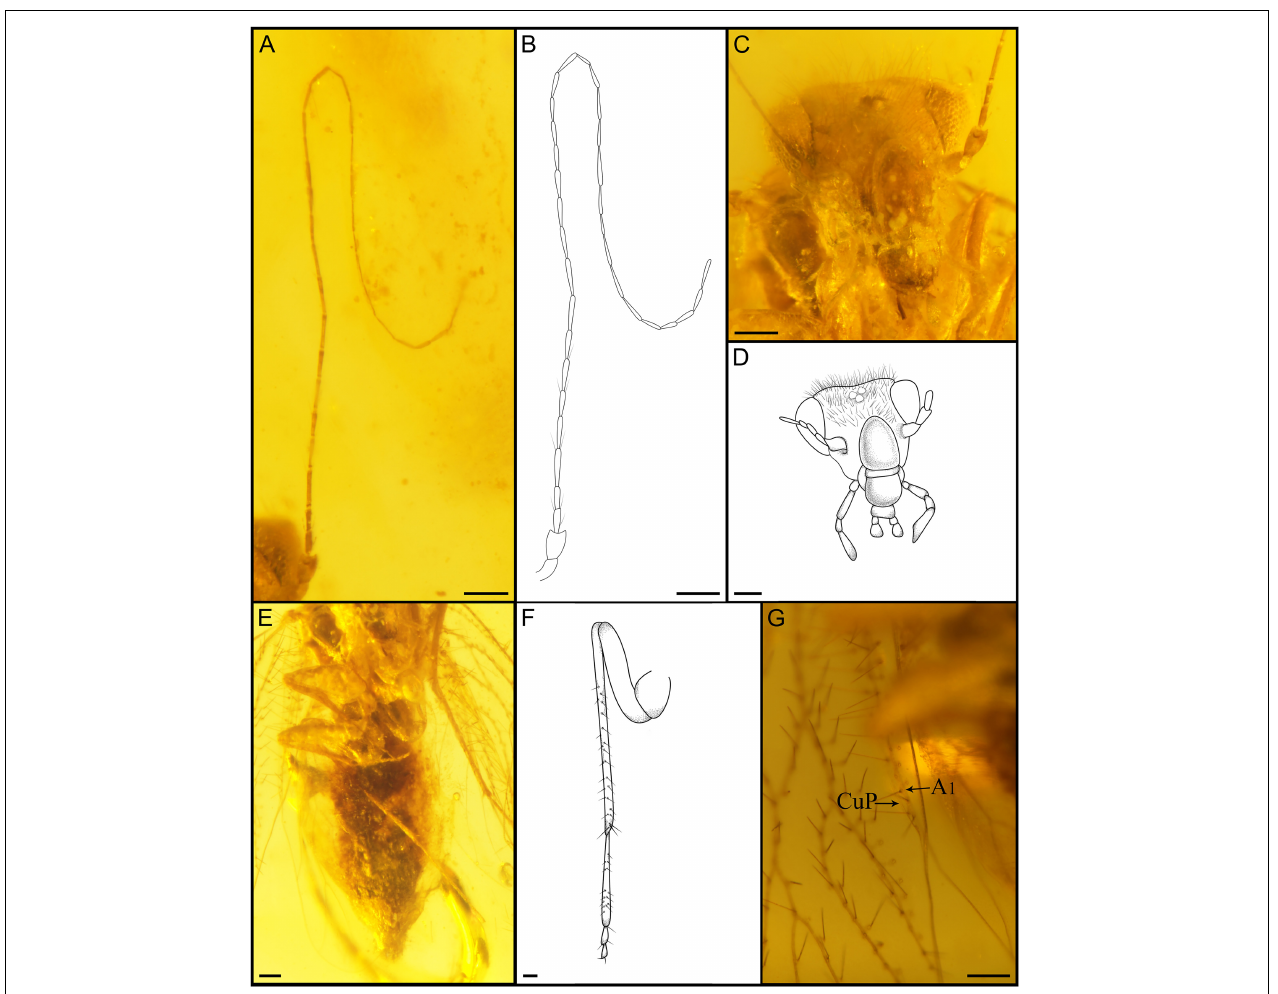
FIGURE 5 | Detailed photograph of Burmempheria curvatavena Li, Yoshizawa and Yao, sp. nov. (A) Photograph of right antenna; (B) line drawing of right antenna; (C) photograph of mouthpart; (D) line drawing of mouthpart; (E) photograph of right hind leg (dorsal view); (F) line drawing of right hind leg (dorsal view); (G) photograph of CuP and A1 in left forewing. Scale bars:0.1